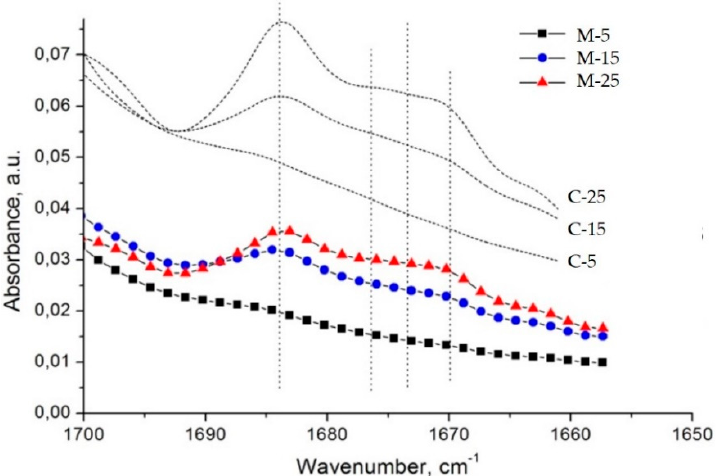
Figure 7. Spectral similarity between the infrared spectra of drug-loaded microsponges (M) and drug–polymer solid dispersions (C) .